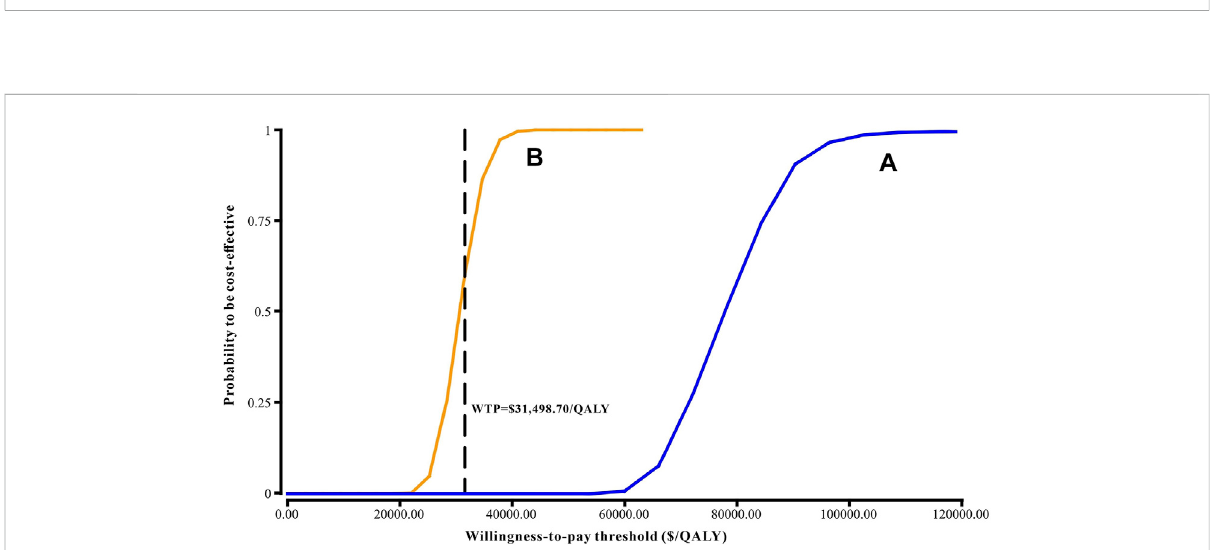
FIGURE 4 A probabilistic scatter plot of the ICER between the olaparib and placebo group. Each dot represents the ICER for one simulation. An ellipse means 95% con fi dence interval. Dots that are located below the ICER threshold represent cost-effective simulations. (A) The base case analysis. (B) 60% discount of olaparib. Abbreviations: WTP